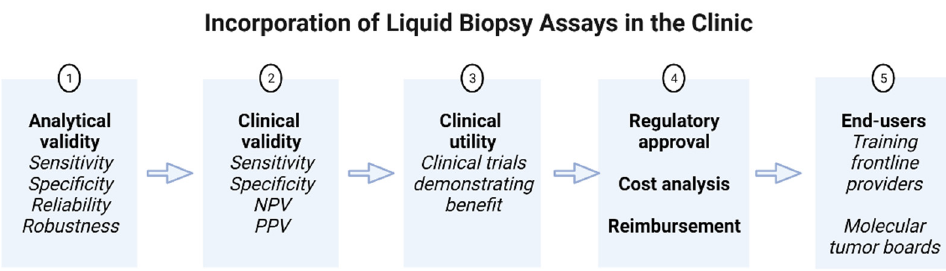
Figure 2. Steps in the incorporation of liquid biopsy assays in clinical practice. NPV, negative pre- dictive value; PPV, positive predictive value.